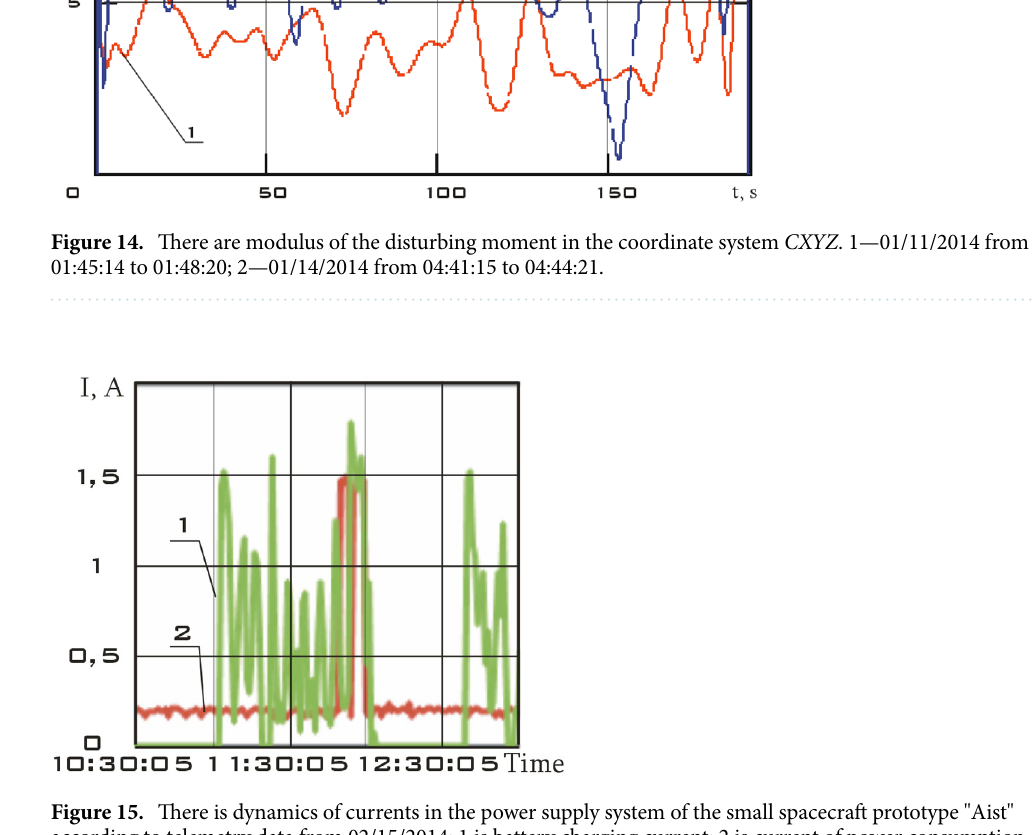
Figure 15. There is dynamics of currents in the power supply system of the small spacecraft prototype "Aist" according to telemetry data from 02/15/2014: 1 is battery charging current; 2 is current of power consumption of scientific